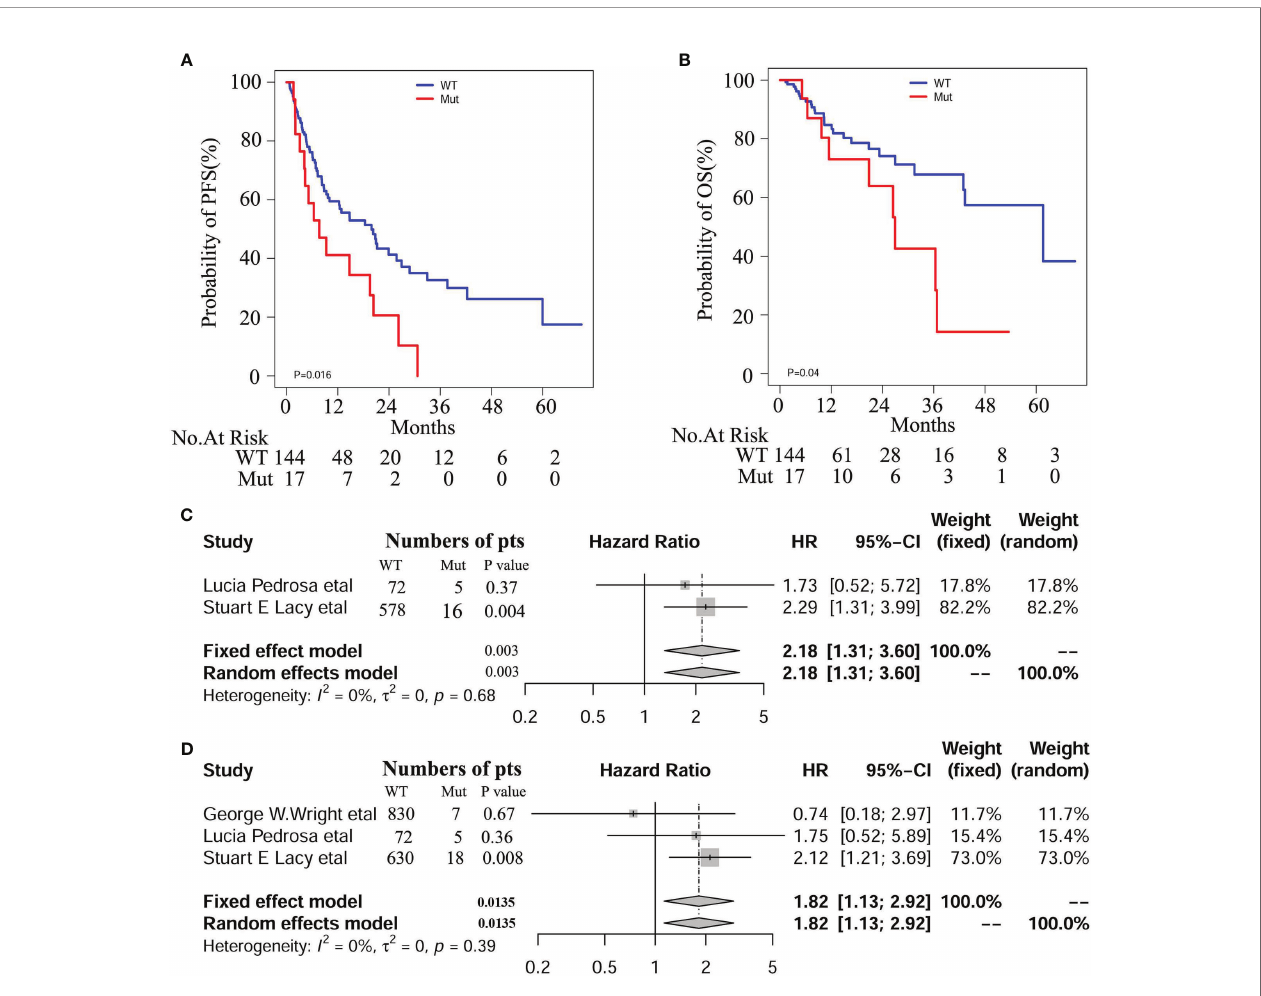
FIGURE 2 | Survival curves of PFS (A) and OS (B) in our DLBCL patients with and with NOTCH1 mutations. Meta-analyses of PFS (C) and OS (D) in the Western cohorts of DLBCL